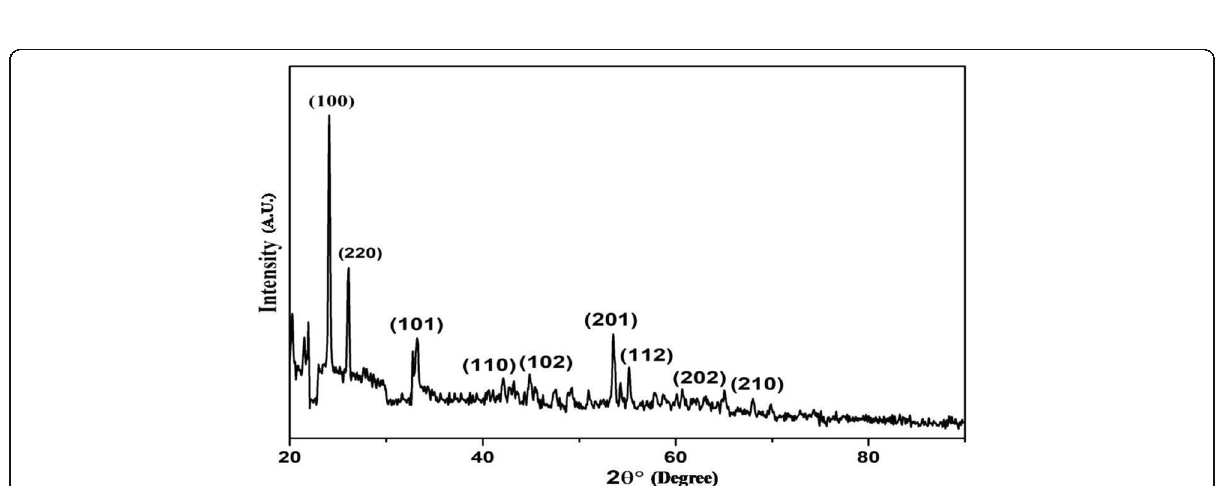
Fig. 8 XRD analysis of biosynthesised selenium nanoparticles